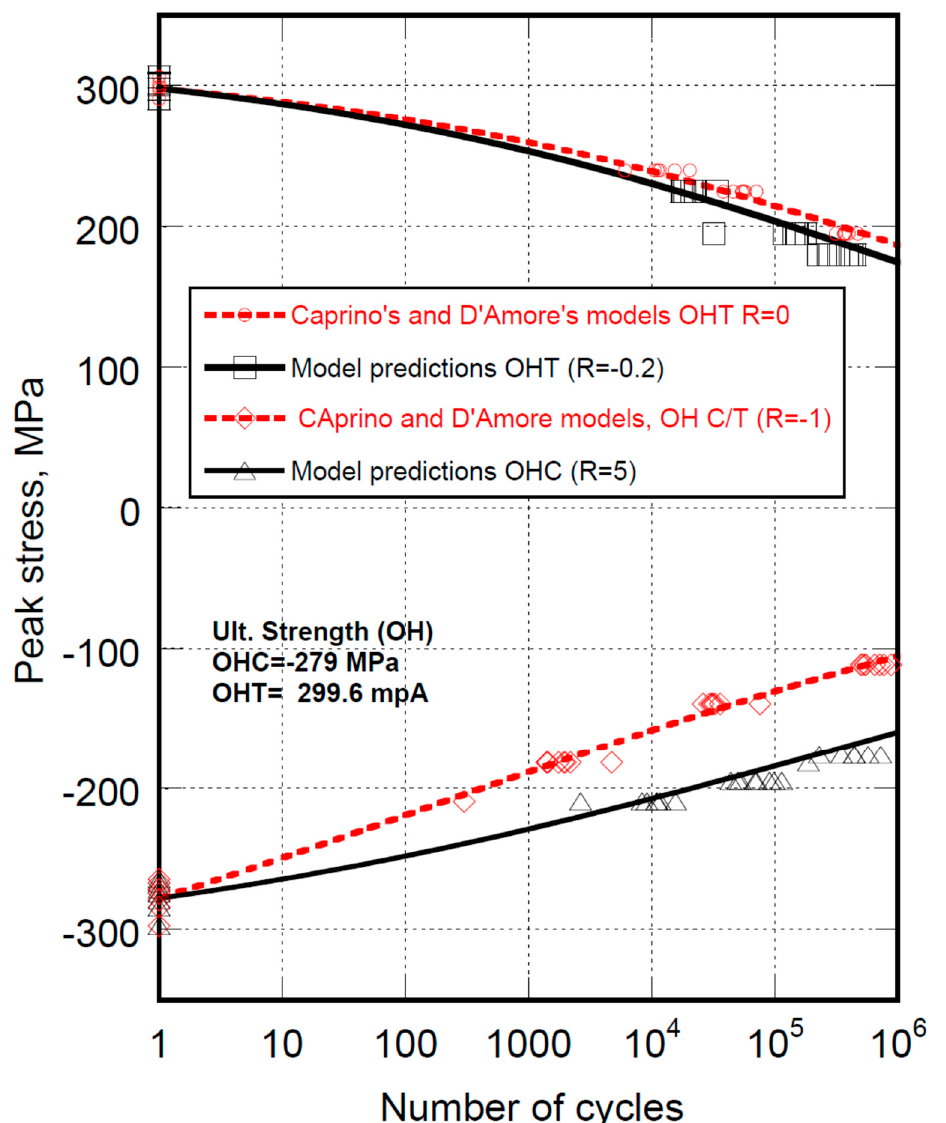
Figure 3. The complete set experimental fatigue life data for AS4/E7K8 PW—10/80/10, OH, at R = 0, R = − 0.2, R = − 1 and R = − 5 and the predictions of equivalent D’Amore’s and Caprino’s models. The data are modeled with a single set of models parameters.